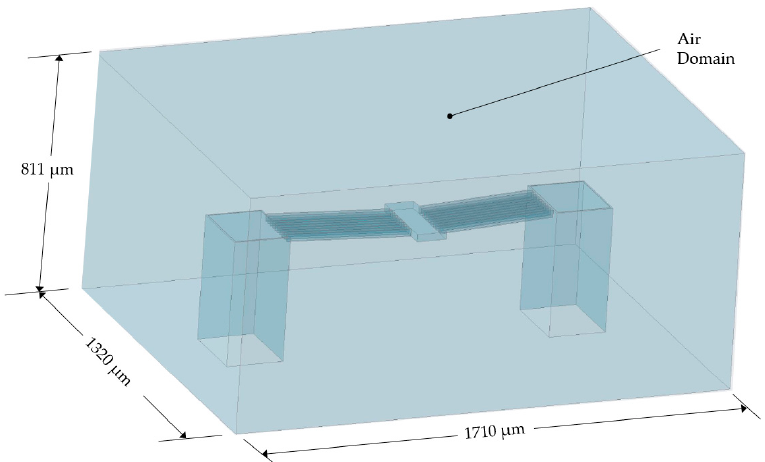
Figure 7. Geometry as prepared for the finite volume model. This geometry was discretised into cells and acted as air in the coupled numerical analysis. Note that from a geometry perspective, the fluid enclosure was modelled as a computer-aided designed ‘solid’ with the V-shaped ETA structure cut away from it. The FSI interface between the finite element and finite volume models was a perfect match at the said cut-out, and this surface set, composing the cut-out, formed the data transfer location. The dimensions are given in micrometres.